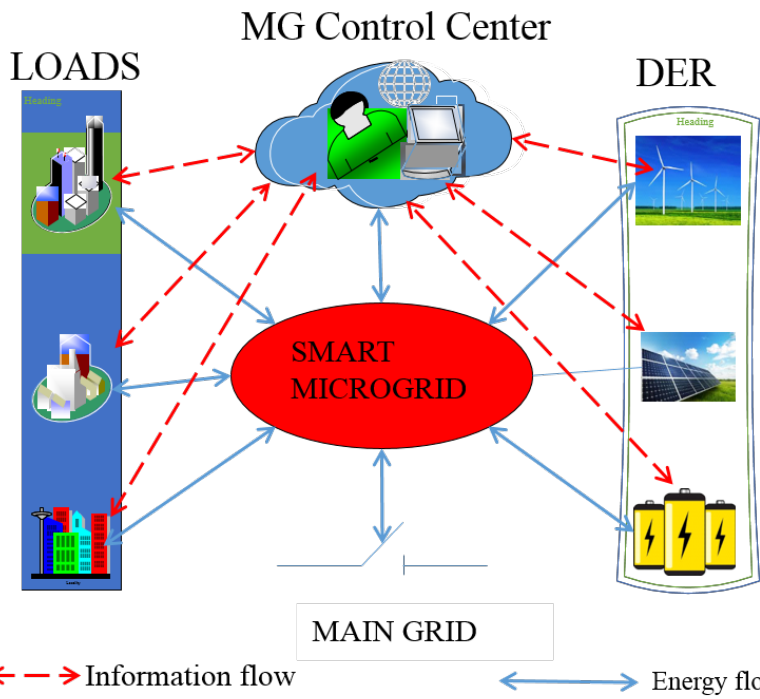
Figure 2. Components of a microgrid [46] showing both energy and information flows. MG: micro-grid; DER: distributed energy